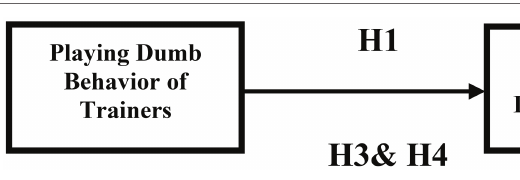
FIGURE 1 | Conceptual